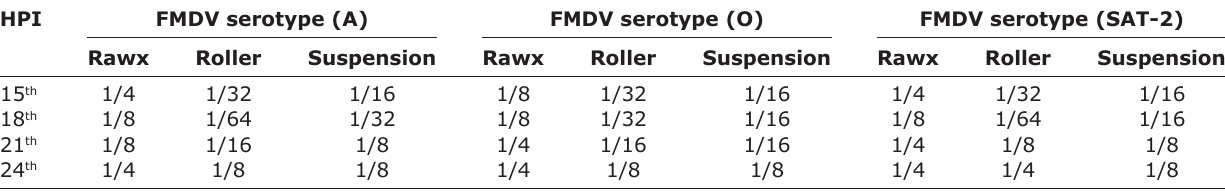
Table-1: Complement fixing titers of FMD virus serotypes using different cell culture systems.